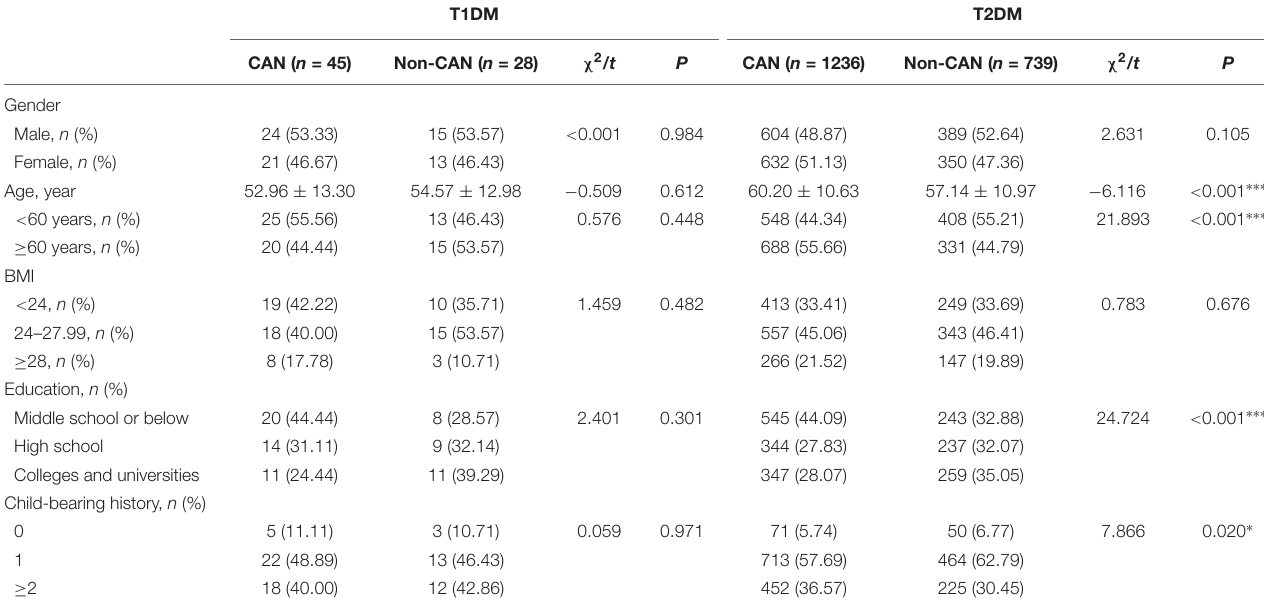
TABLE 1 | General characteristics of T1DM and T2DM patients by CAN